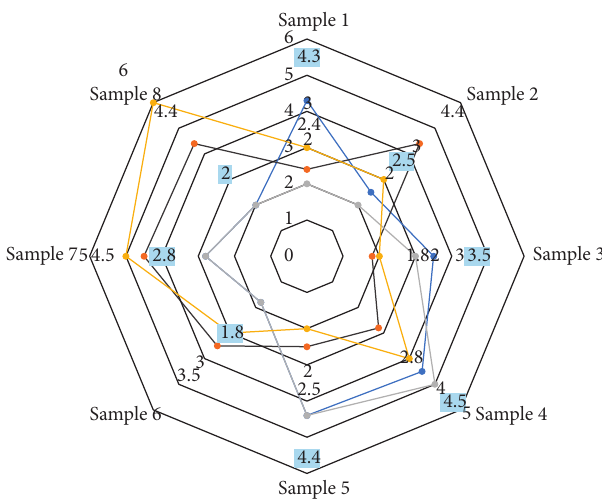
Figure 5: Data regulation trends of cloud computing